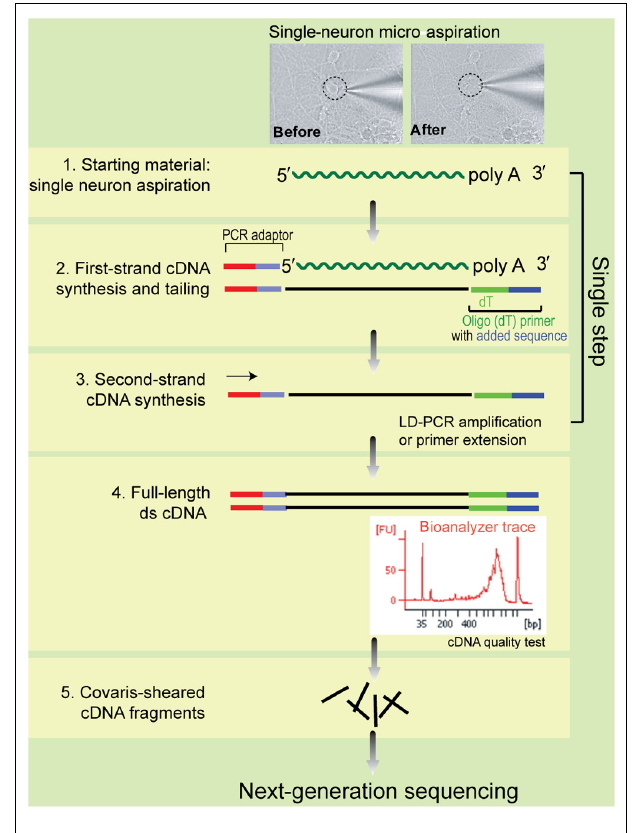
FIGURE 1 | Experimental design of the single-neuron RNA-Seq method reported in this